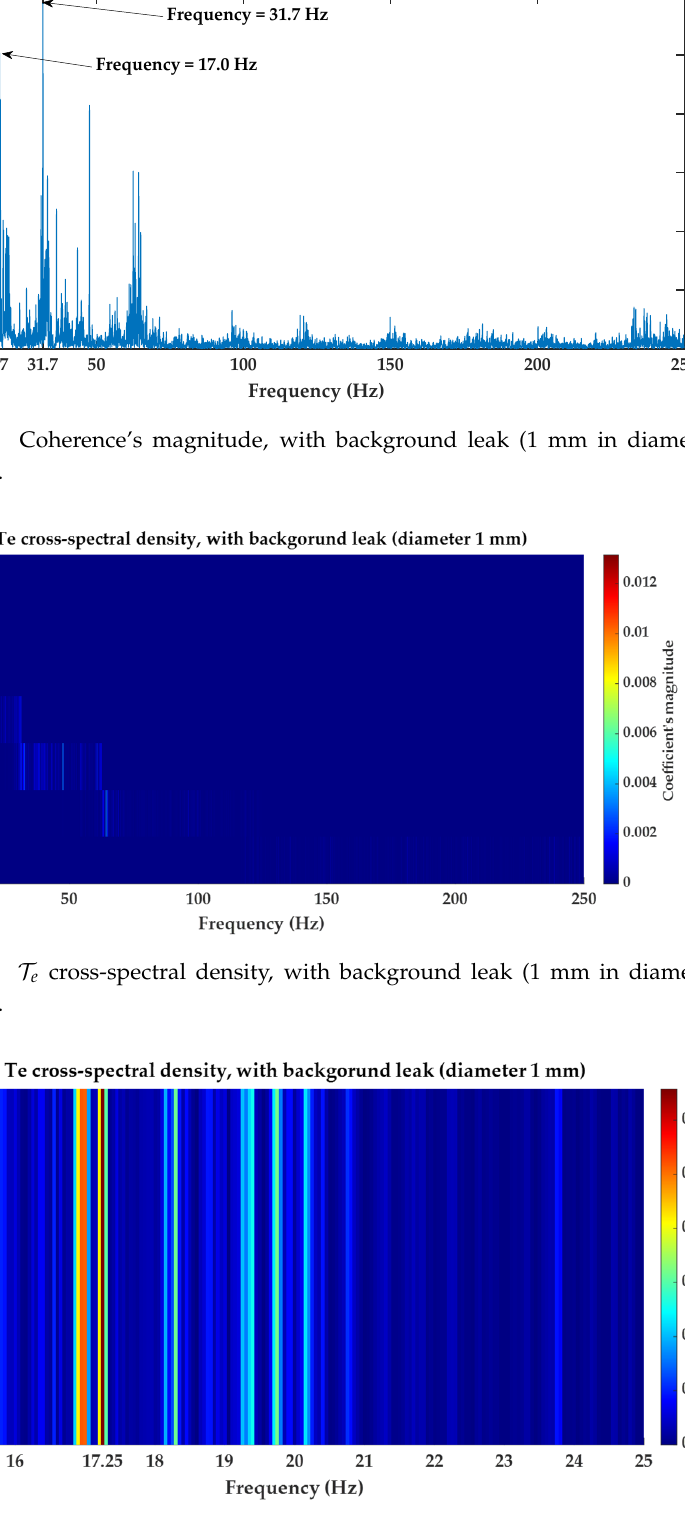
Figure 13. 𝒯 (cid:3032) cross-spectral density in Scale 4 , with background leak ( 1 mm in diameter) and flow Figure 13. T e cross-spectral density in Scale 4, with background leak (1 mm in diameter) and flow rate 33.7 mL/s . rate 33.7